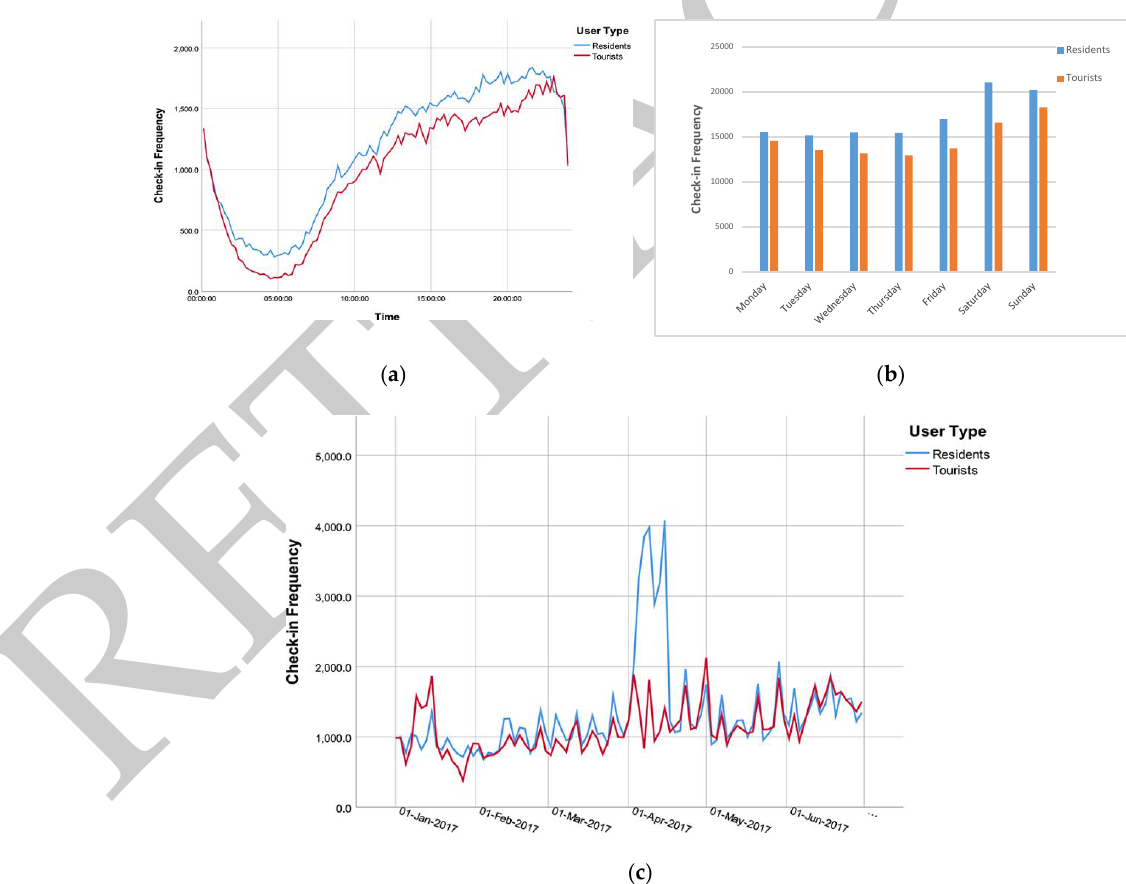
Figure 6. ( a ) Daily check-in frequencies. ( b ) Weekly check-in frequencies. ( c ) Check-in frequencies of tourists and residents for six months.